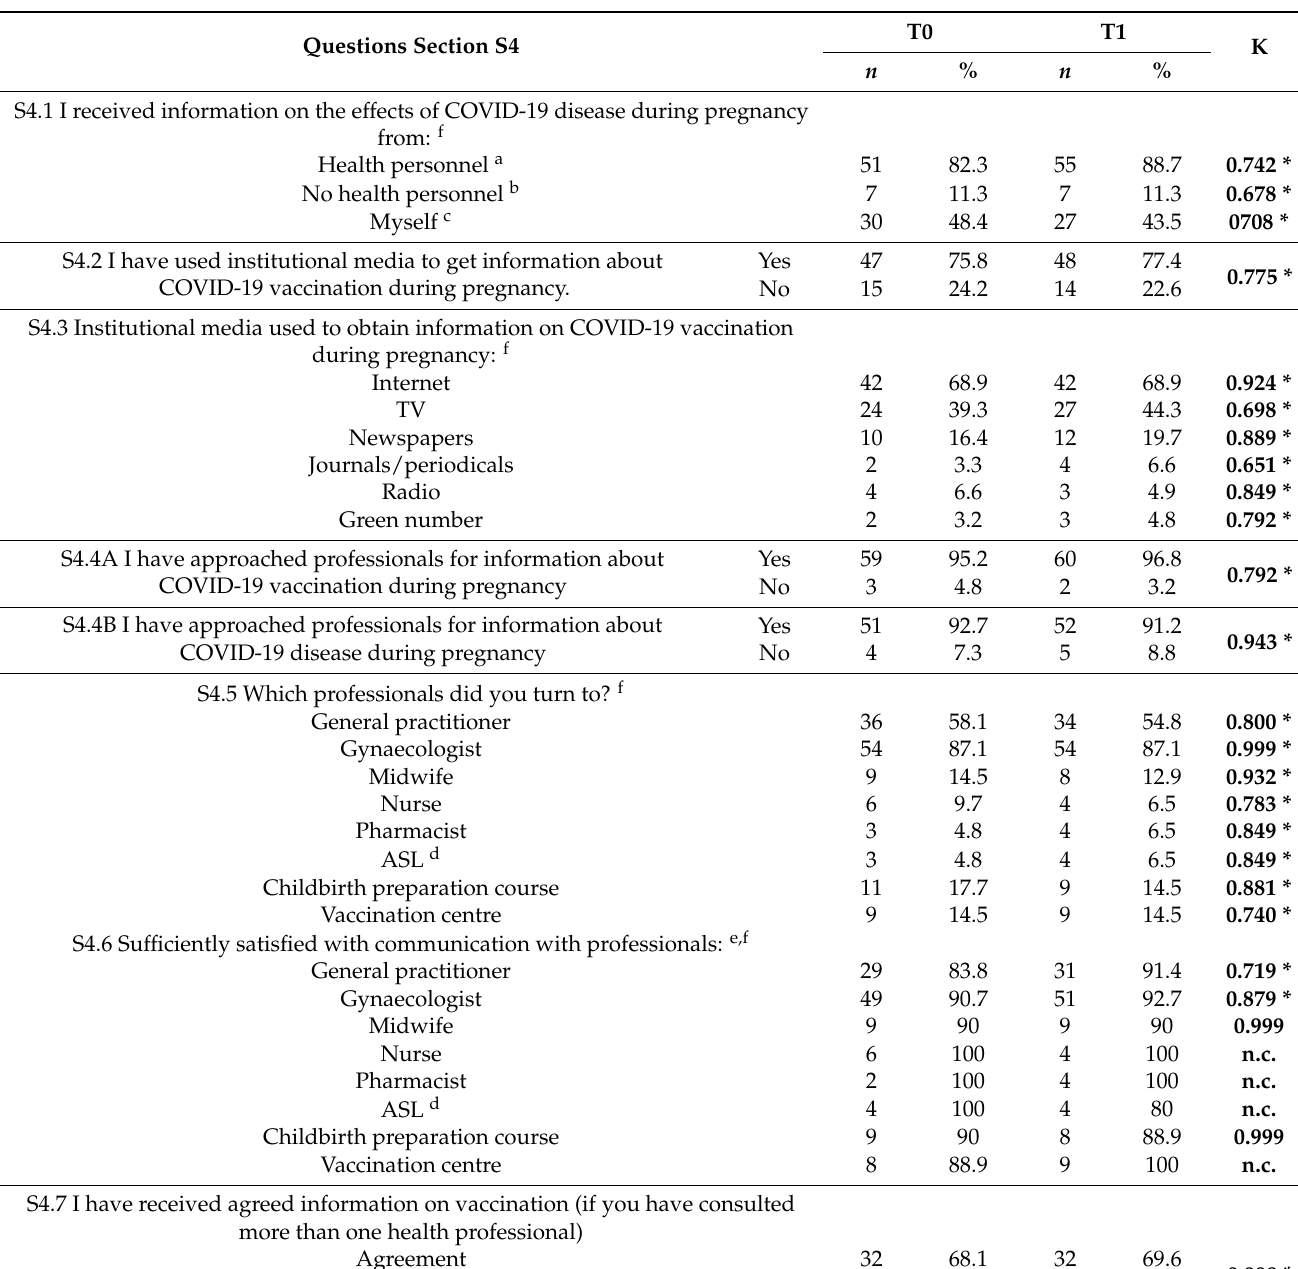
Table 5. Descriptive and reliability of “Section S4: Sources of information used on vaccination and impact of COVID-19 disease” ( n =